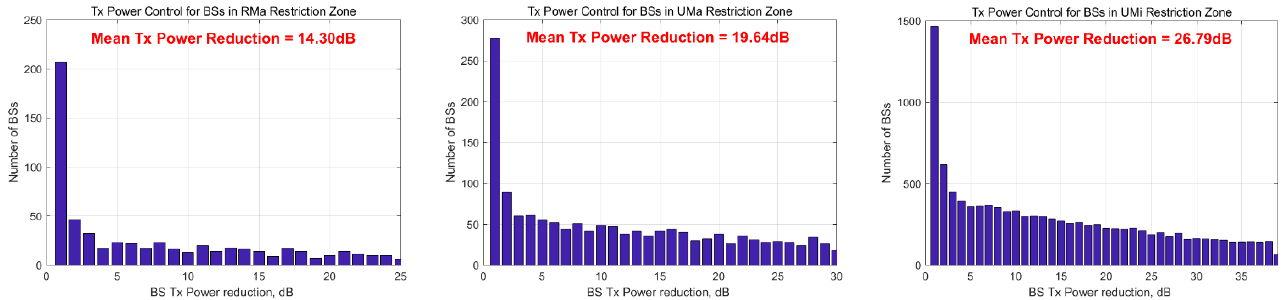
Figure 25. Mean Tx power reduction for the BS versus the number of BSs.